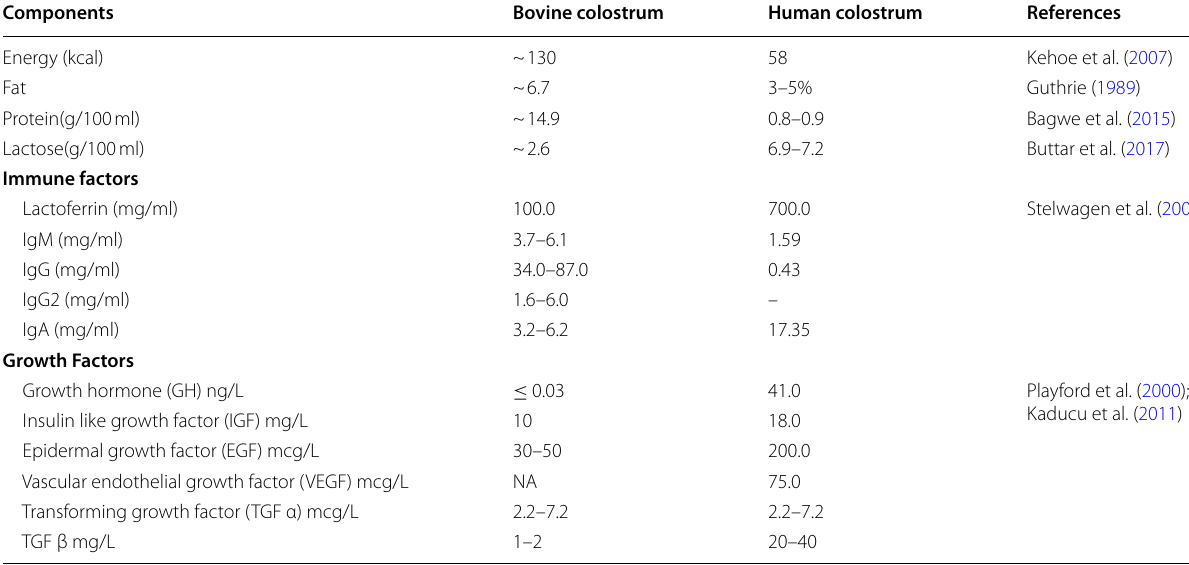
Table 3 Comparison of bovine colostrum with human colostrum